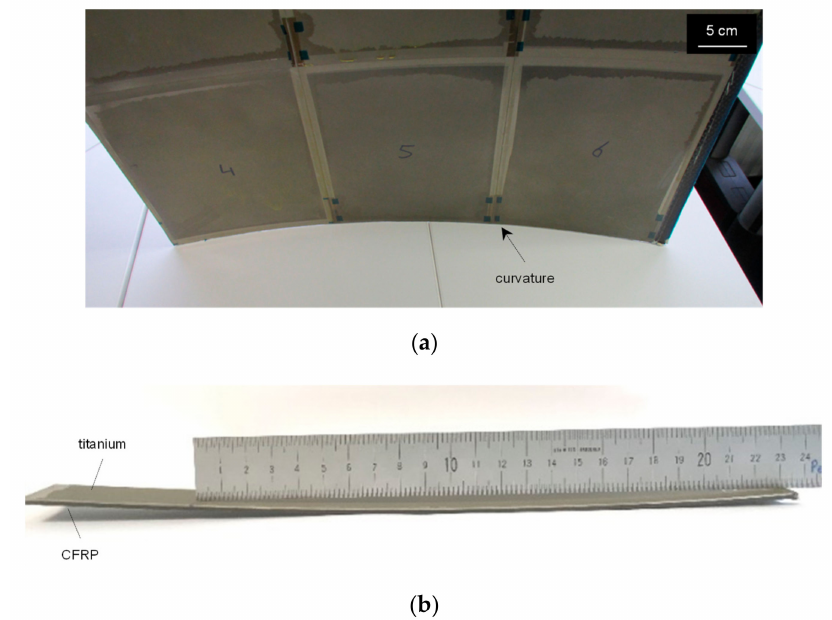
Figure 2. Photographs of the produced titanium–CFRP adhesive joint (reproduced from [19], with permission from Elsevier, 2020). ( a ) All produced panels showed intense curvature as a result of the manufacturing-induced residual thermal stresses. ( b ) The specimens cut from the panels also show an intense curvature along their